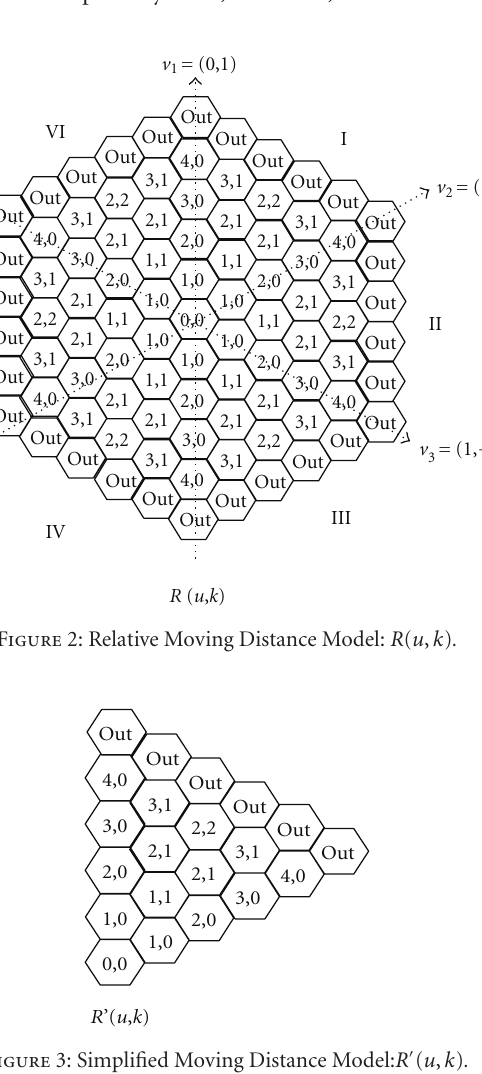
actually the Region I of the original Relative Moving Distance model. The cell in the Simplified Moving Distance model is denoted as R (cid:3) ( u , k ), where u , k are non-negative integers and u ≥